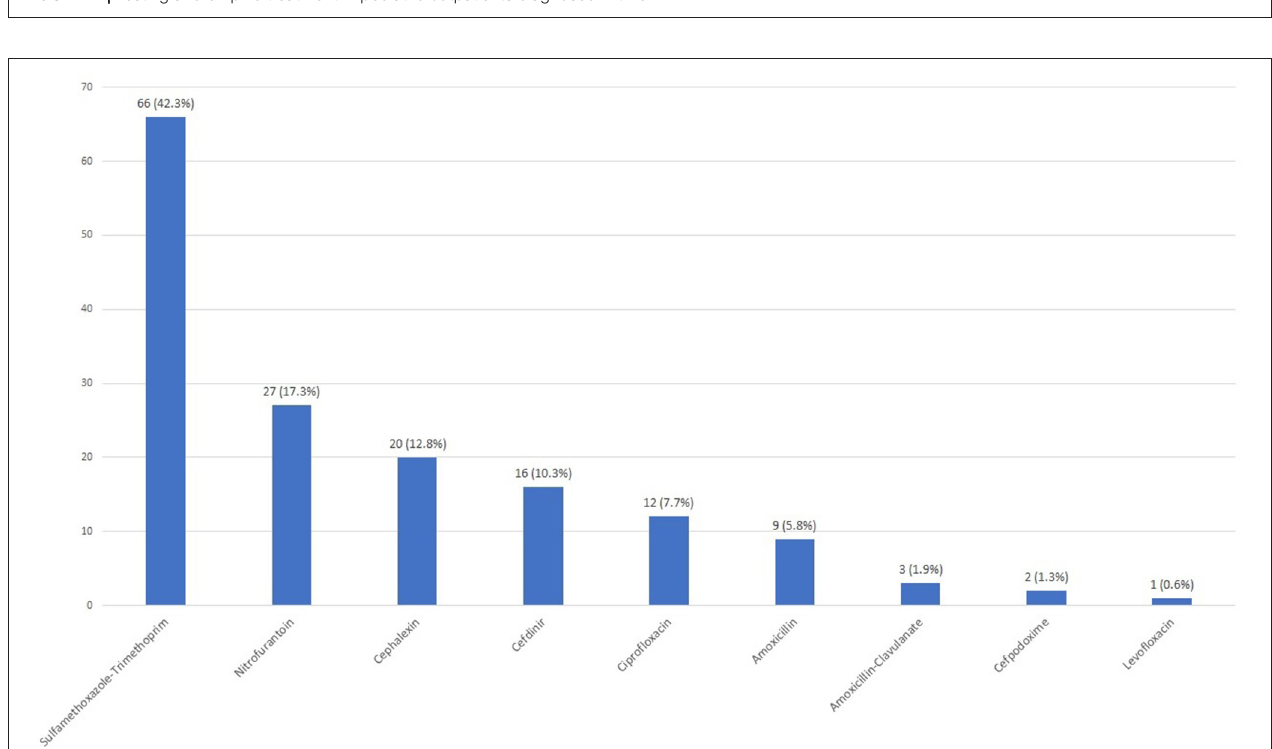
FIGURE 2 | Empiric antibiotic selection. Each bar shows number of patients prescribed in the indicated antibiotic with n (%) noted above.